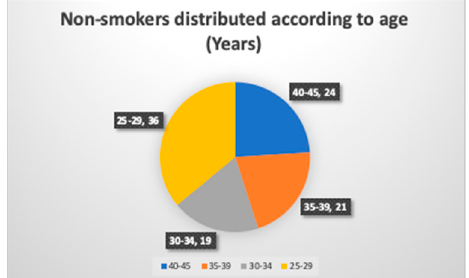
Figure 4. Age wise distribution of smokers.